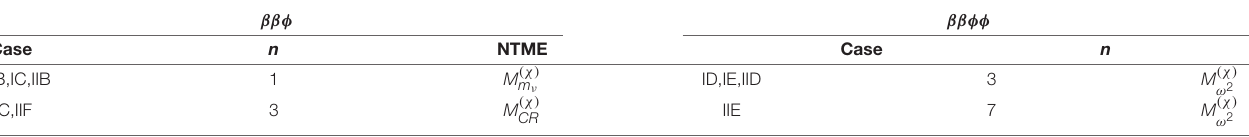
TABLE 3 | Different Majoron models according to Bamert et al. [114].